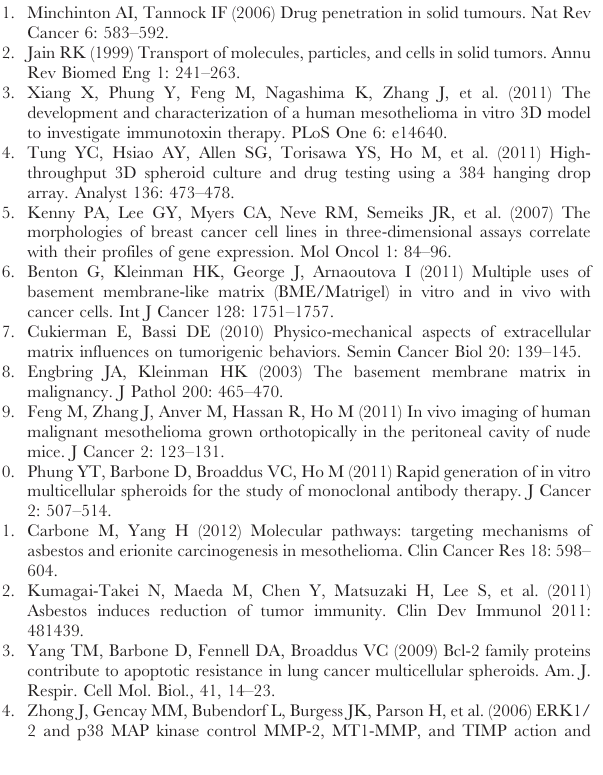
Table S1 List of 142 genes differentially expressed with a five or greater fold change in